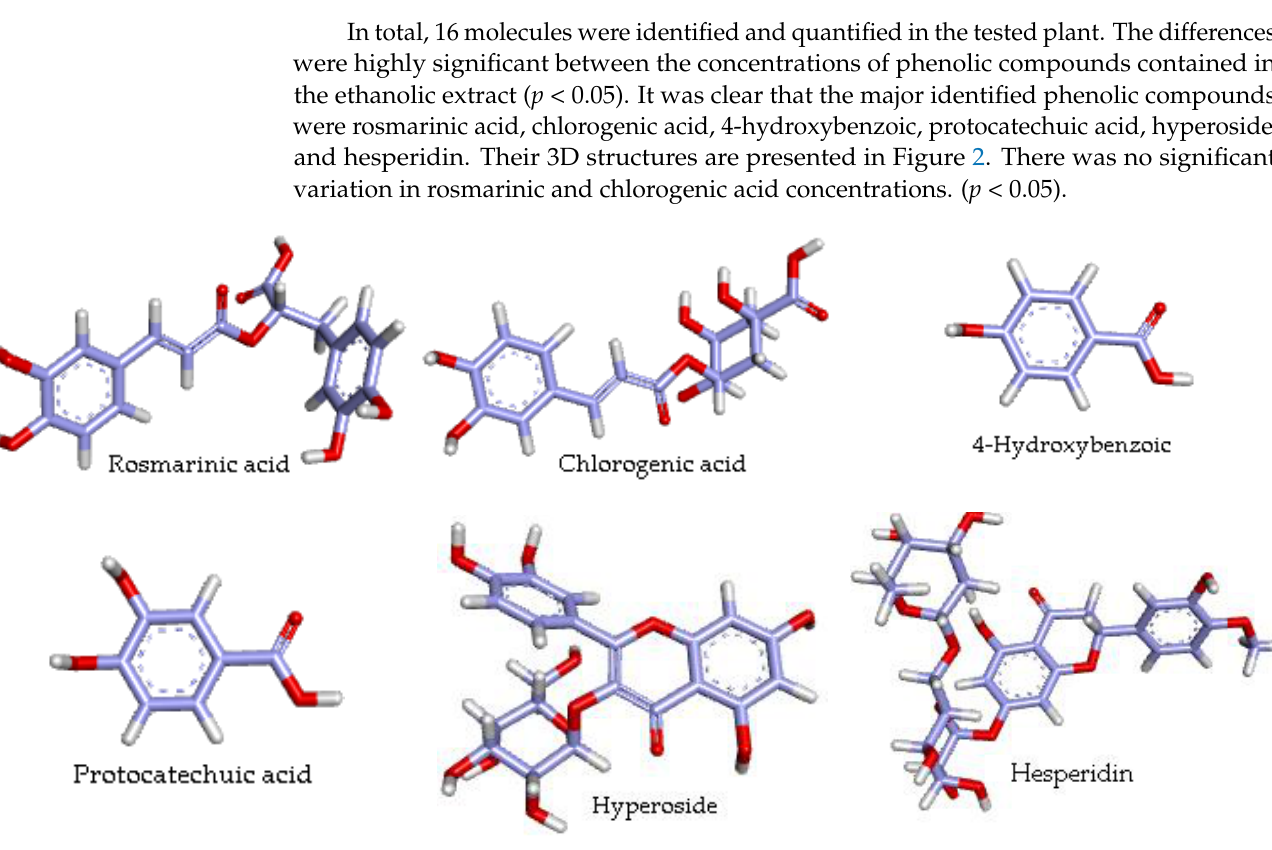
Figure 2. The 3D structures of the most abundant compounds in A. armatus extract visualized using Discovery